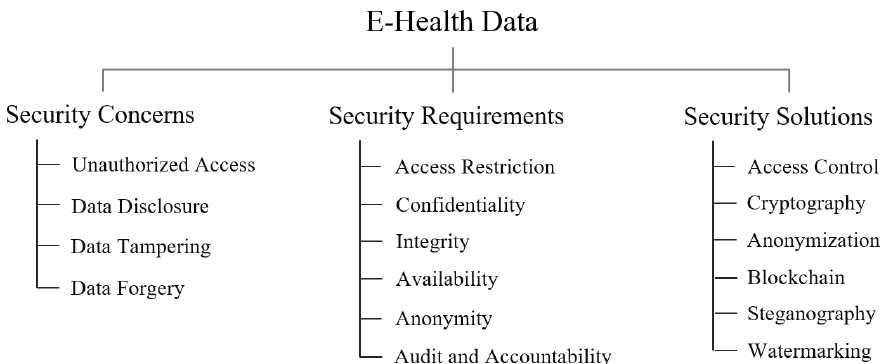
Figure 3. A taxonomy on the security and privacy for e-health